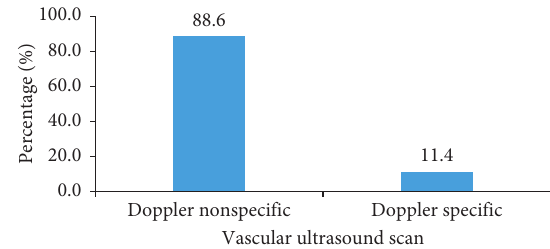
Figure 3: Category of request for vascular